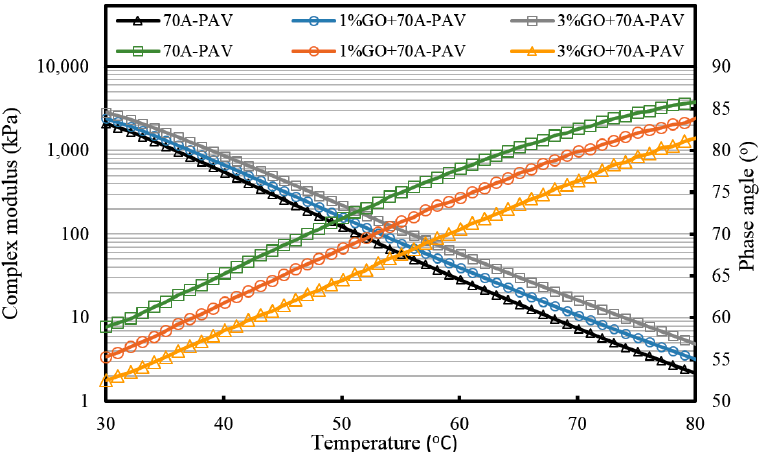
Figure 9. Complex modulus and phase angle of GO-modified 70A and its matrix at high temperature after PAV aging.